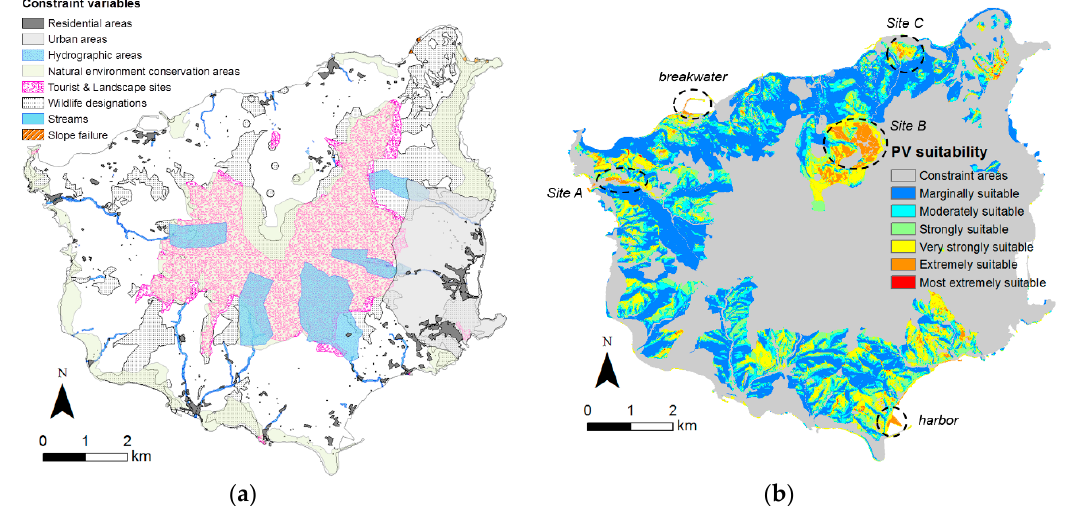
Figure 3. PV solar farm evaluation for Ulleung Island, Korea using the FAHP method: ( a ) Distribution of constraint areas; ( b ) Suitability index for a PV solar farm (Suh and Brownson [49]).